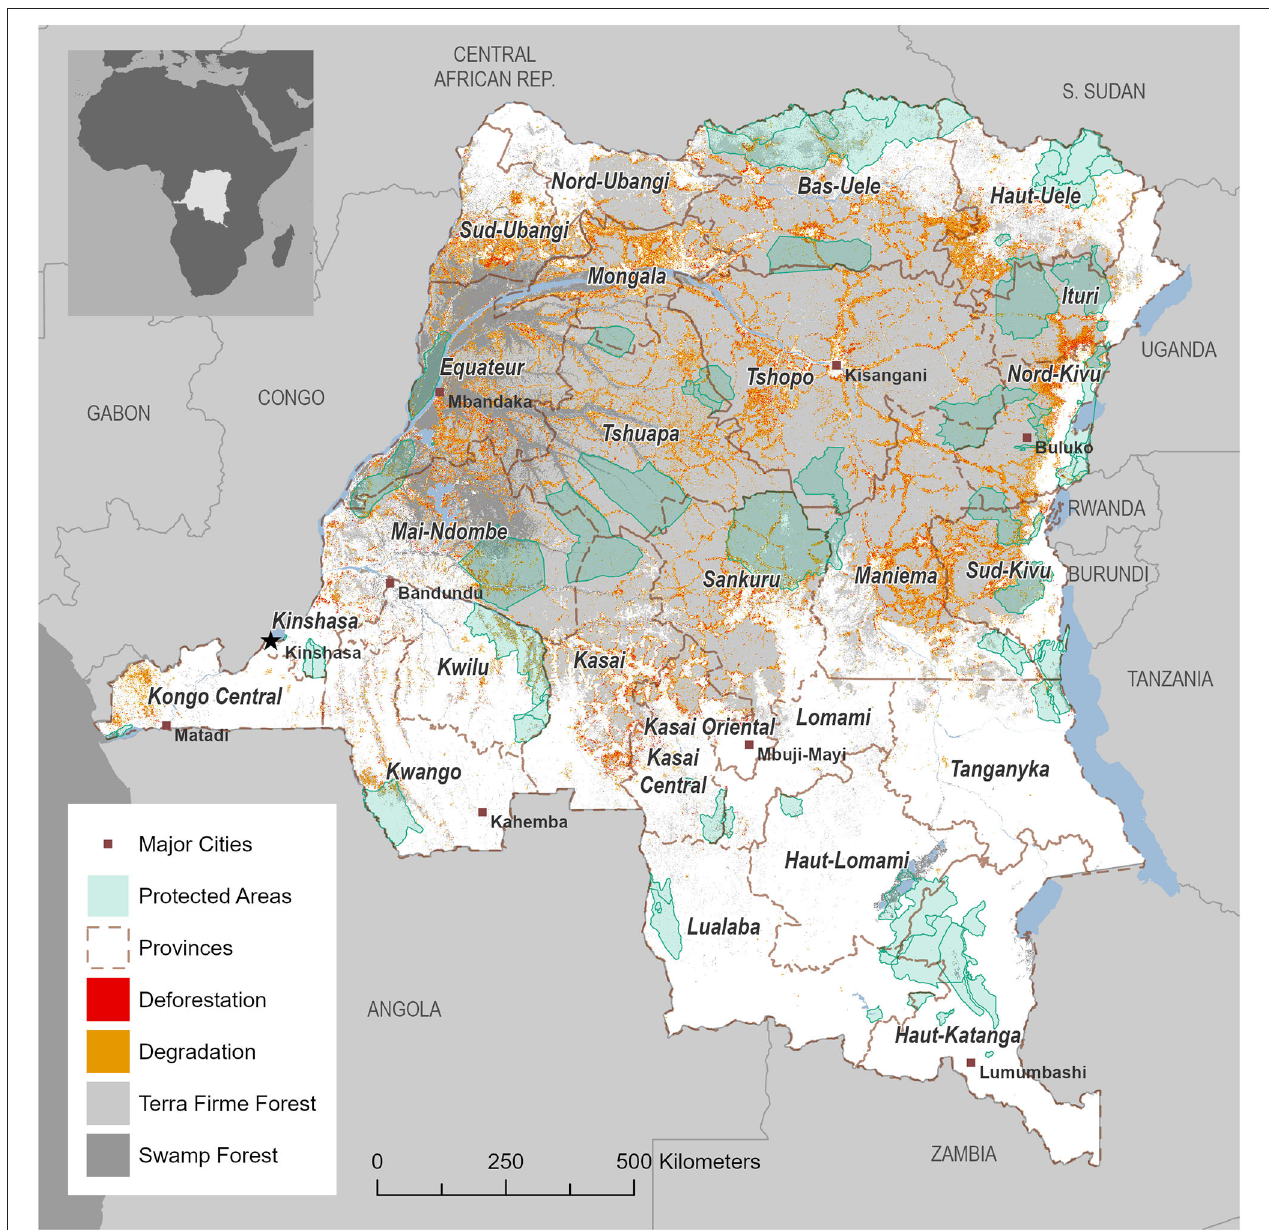
FIGURE 1 | The Democratic Republic of the Congo (DRC), with the capital Kinshasa, divided into 26 provinces, possesses over 100 million ha of tropical forest, of which about 11 million are swamp forest. Deforestation and degradation is from Shapiro et al.